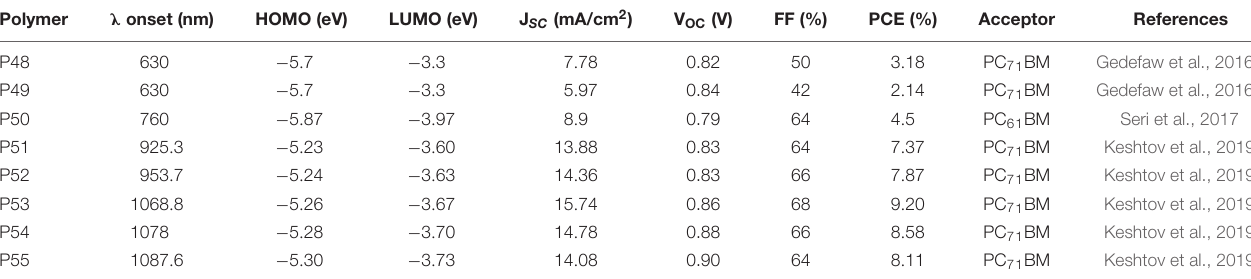
TABLE 5 | Summary of optical, electrochemical, and photovoltaic properties of polymers ( P48 – P55 ).